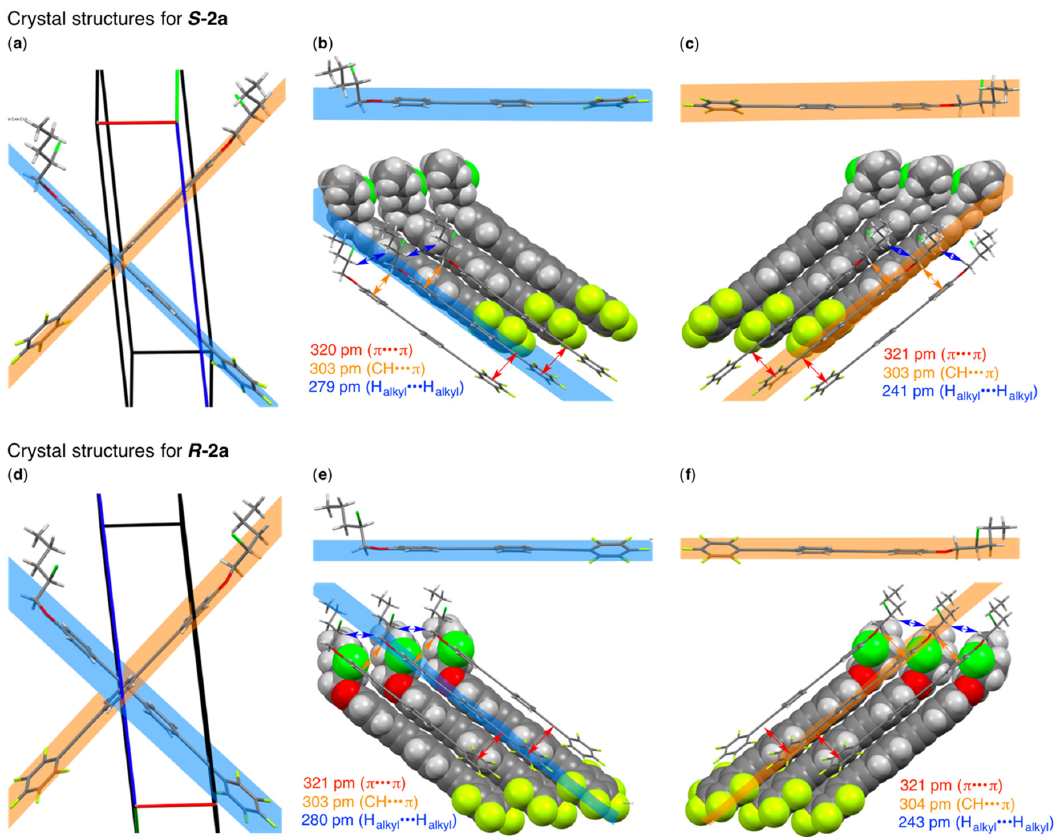
Figure 4. ( a ) Crystal structures in a unit cell and ( b , c ) (top) side view and (bottom) packing structures for S -2a . ( d ) Crystal structures in a unit cell and ( e , f ) (top) side view and (bottom) packing structures for R -2a . Arrows: shortest contact for π ··· π (red), for CH··· π (yellow), and for H···H (blue).